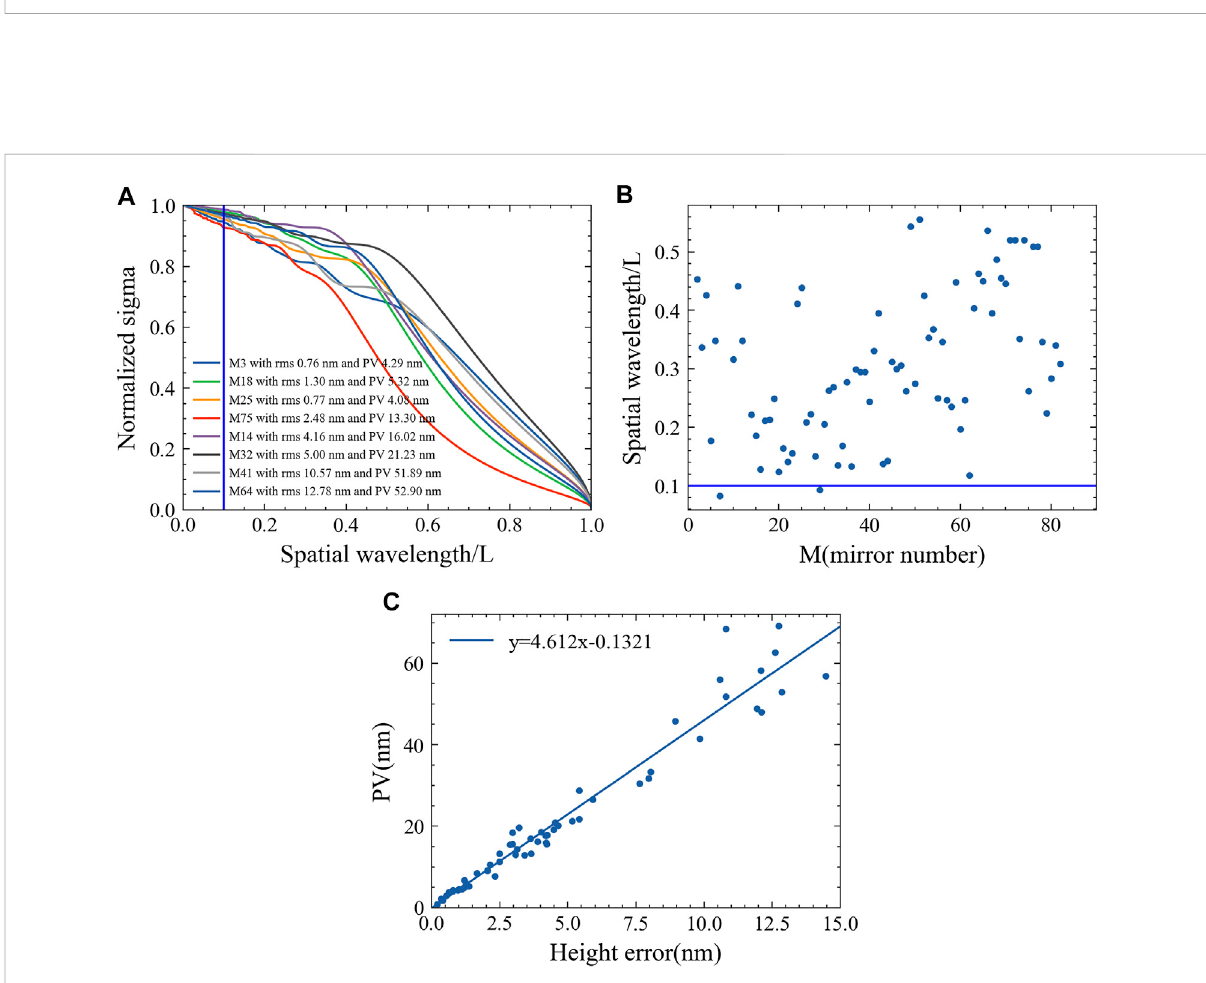
FIGURE 6 (A) The relationshape between σ Normalized with the spatial wavelength (/L). (B) the spatial wavelength (/L) of error for existing mirrors in DABAM when the σ Normalized reach 0.8. (C) the relationshape between PV with RMS of height